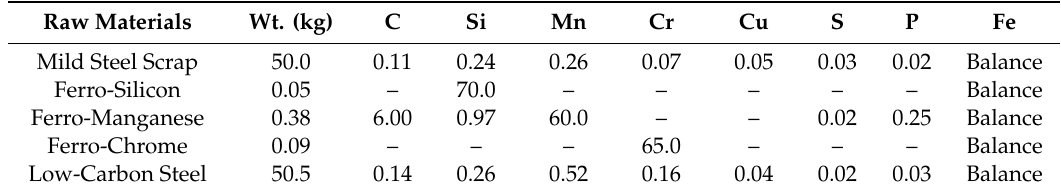
Table 1. Composition (wt%) and weight (kg) of raw materials usedin steel production. Raw Materials Wt. (kg) Mild Steel Scrap Ferro-Manganese Ferro-Chrome Low-Carbon